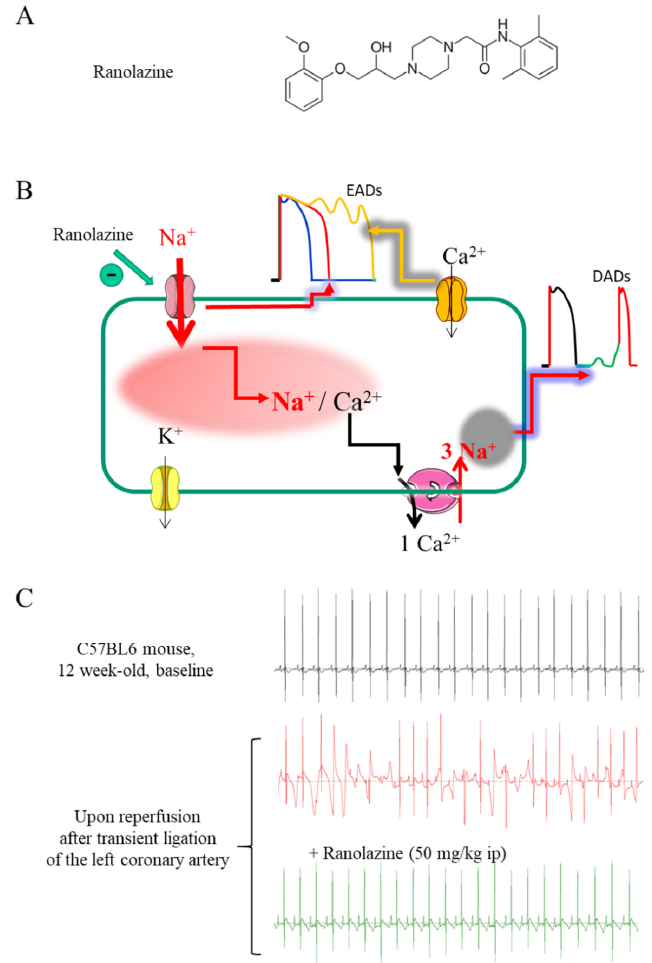
Figure 1. Benefits of I Na,late inhibition by ranolazine on cellular cardiac action potential (AP) and Na + /Ca 2+ ion homeostasis, and antiarrhythmic effects. ( A ) Chemical structure of Ranolazine. ( B ) Cel- lular impact of the sustained entry of Na + caused by I Na,late in cardiomyocytes. Two mechanisms cooperate: ( i ) the transmembrane influx of Na + , which maintains depolarization during the plateau phase of the action potential and can generate a re-activation of the Ca 2+ channels responsible for early after depolarisations (EADs); ( ii ) the increase in intracellular Na + , which promotes an increase in intracellular Ca 2+ and the occurrence of Ca 2+ -dependent delayed after depolarizations (DADs). Ranolazine prevents both mechanisms by shortening the AP and decreasing intracellular Na + and Ca 2+ in the presence of an I Na,late . ( C ) Typical electrocardiograms, recorded in 12-week-old male C57BL6 mice under gas anesthesia (Isoflurane 2.5%), during baseline conditions ( upper panel ) and after reperfusion following 25 min of ligation of the left coronary artery in the absence (middle panel) and in the presence of ranolazine (50 mg/kg i.p.) ( lower panel ) (unpublished personal